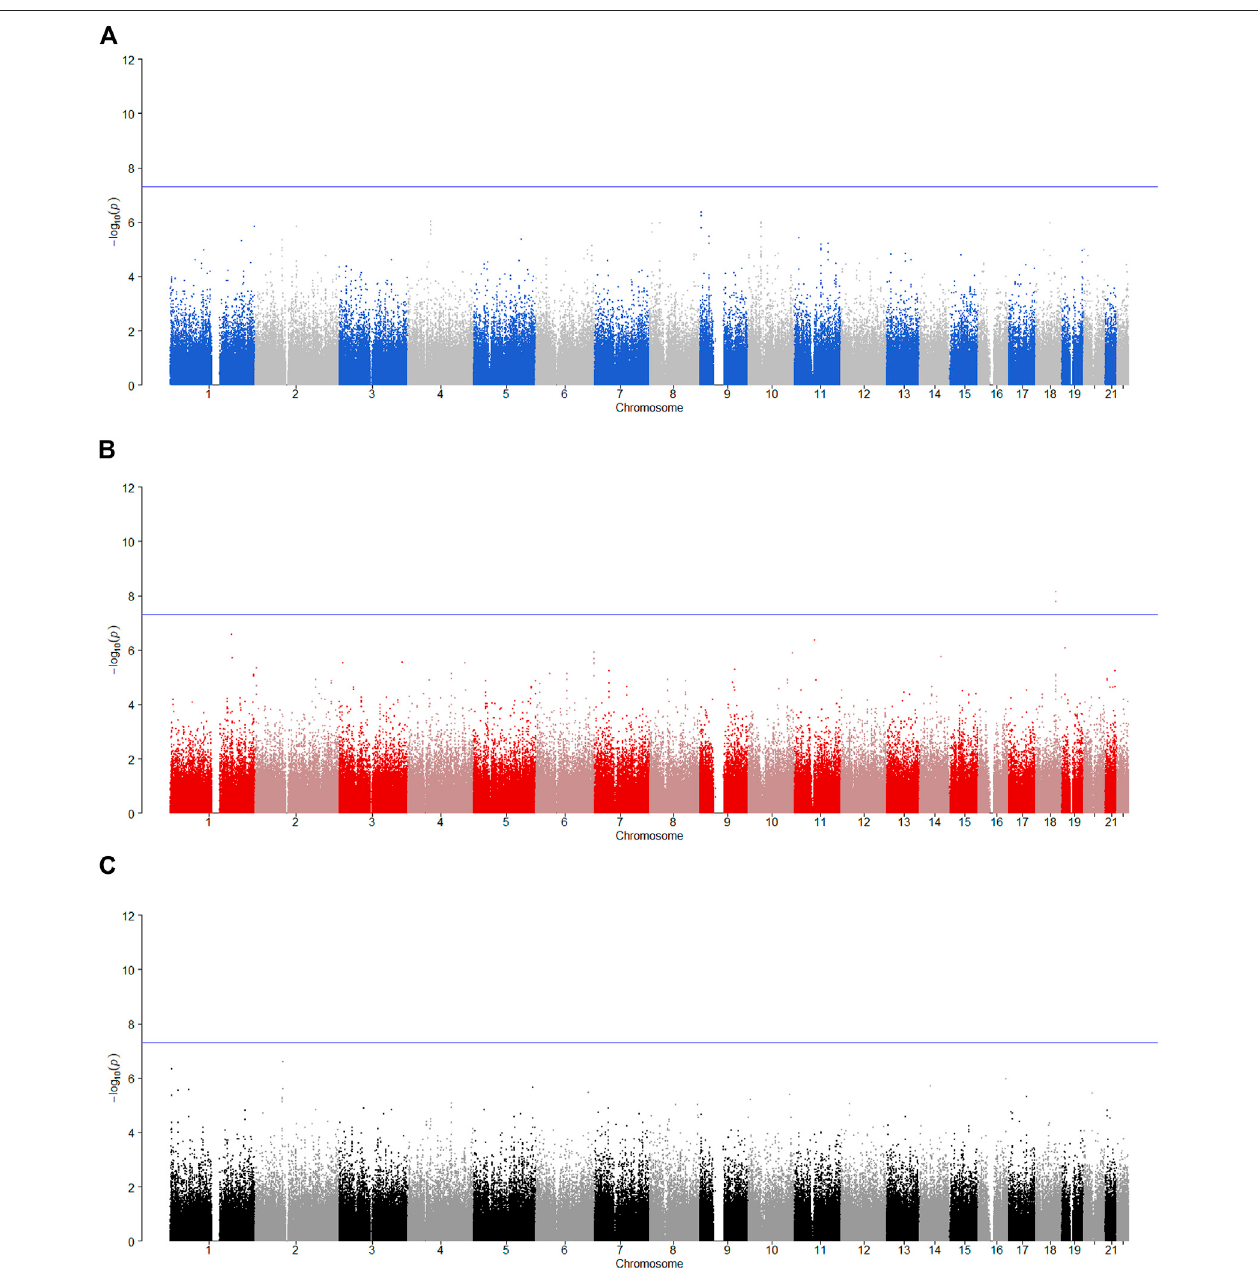
FIGURE 3 | Manhattan plot for POE and genotypic effect tests of alcohol consumption ( N = 2,185). The blue line represents the signi fi cance level α (cid:1) 5 × 10 − 8 , which is the signi fi cance level of GWAS. (A) Paternally derived effect, (B) maternally derived effect and (C) genotypic effect.